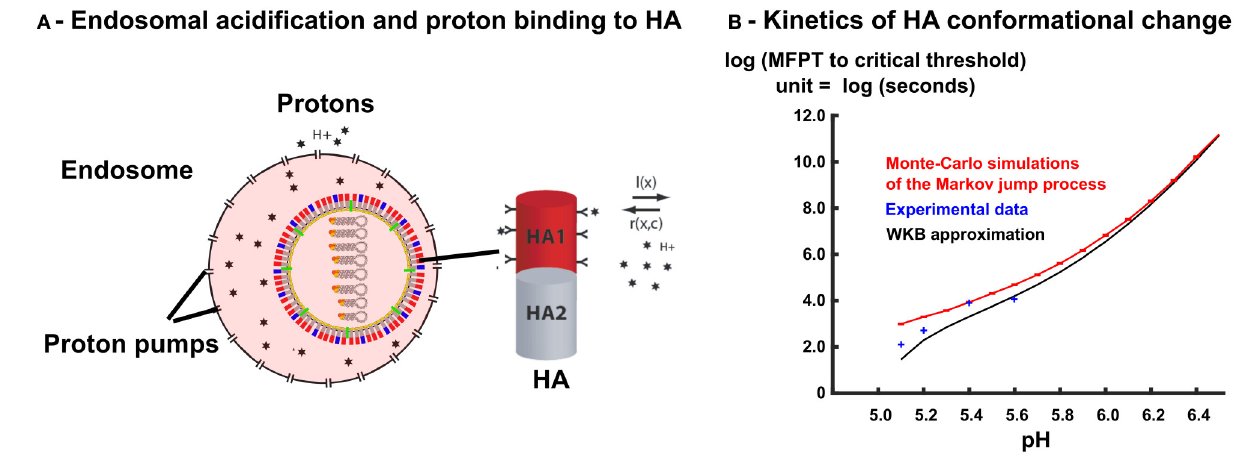
FIGURE 3 | Free protons in the endosome triggers HA conformational change. (A) The right-hand side shows a scheme of an isolated HA trimer. Free protons in the endosome can bind to HA trimers. The protons binding rates r ( X , c ) and l ( X ) depend on the number of occupied sites X and on the concentration c of free protons in the endosome. When the number of bound protons reaches a given threshold, the HA trimer changes conformation into a fusogenic state. (B) MFPT of a discrete Markov jump process with transition rates r ( X , c ) and l ( X ) to a critical threshold n T compared with WKB approximation (solid black line) and experimental data points [